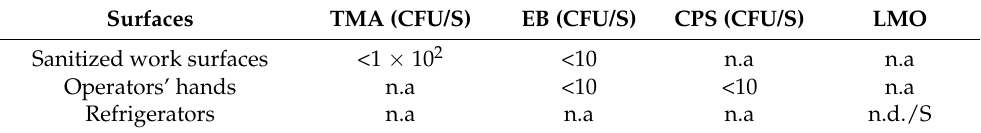
Table 3. Microbiological reference limits for environmental swabs.